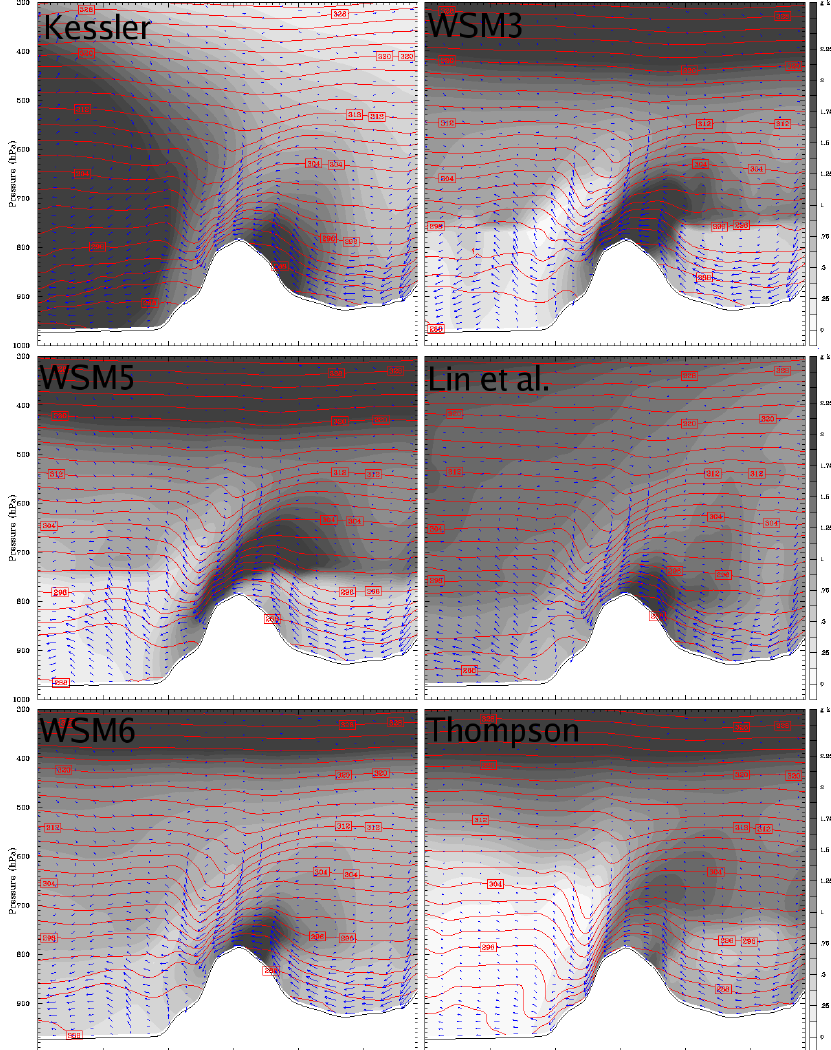
Figure 11: Cross section along line AB (cf. Fig. 4) showing potential temperature Fig. 11. Cross section along line AB (cf. Fig. 4) showing potential temperature (red lines) [K], wind along cross section (blue arrows) (red lines) [K], wind along cross section (blue arrows) [ms − 1 ], and total precipita- [ms − 1 ], and total precipitation mixing ratio [g/kg] at 09:00UTC 16 September 2004. micro-physics schemes are, from top left to bottom tion mixing ratio [g/kg] at 0900 UTC 16 September 2004. micro-physics schemes right: Kessler, WSM3, WSM5, Lin et al., WSM6 and are, from top left to bottom right: Kessler, WSM3, WSM5, Lin et al., WSM6 and Thompson.